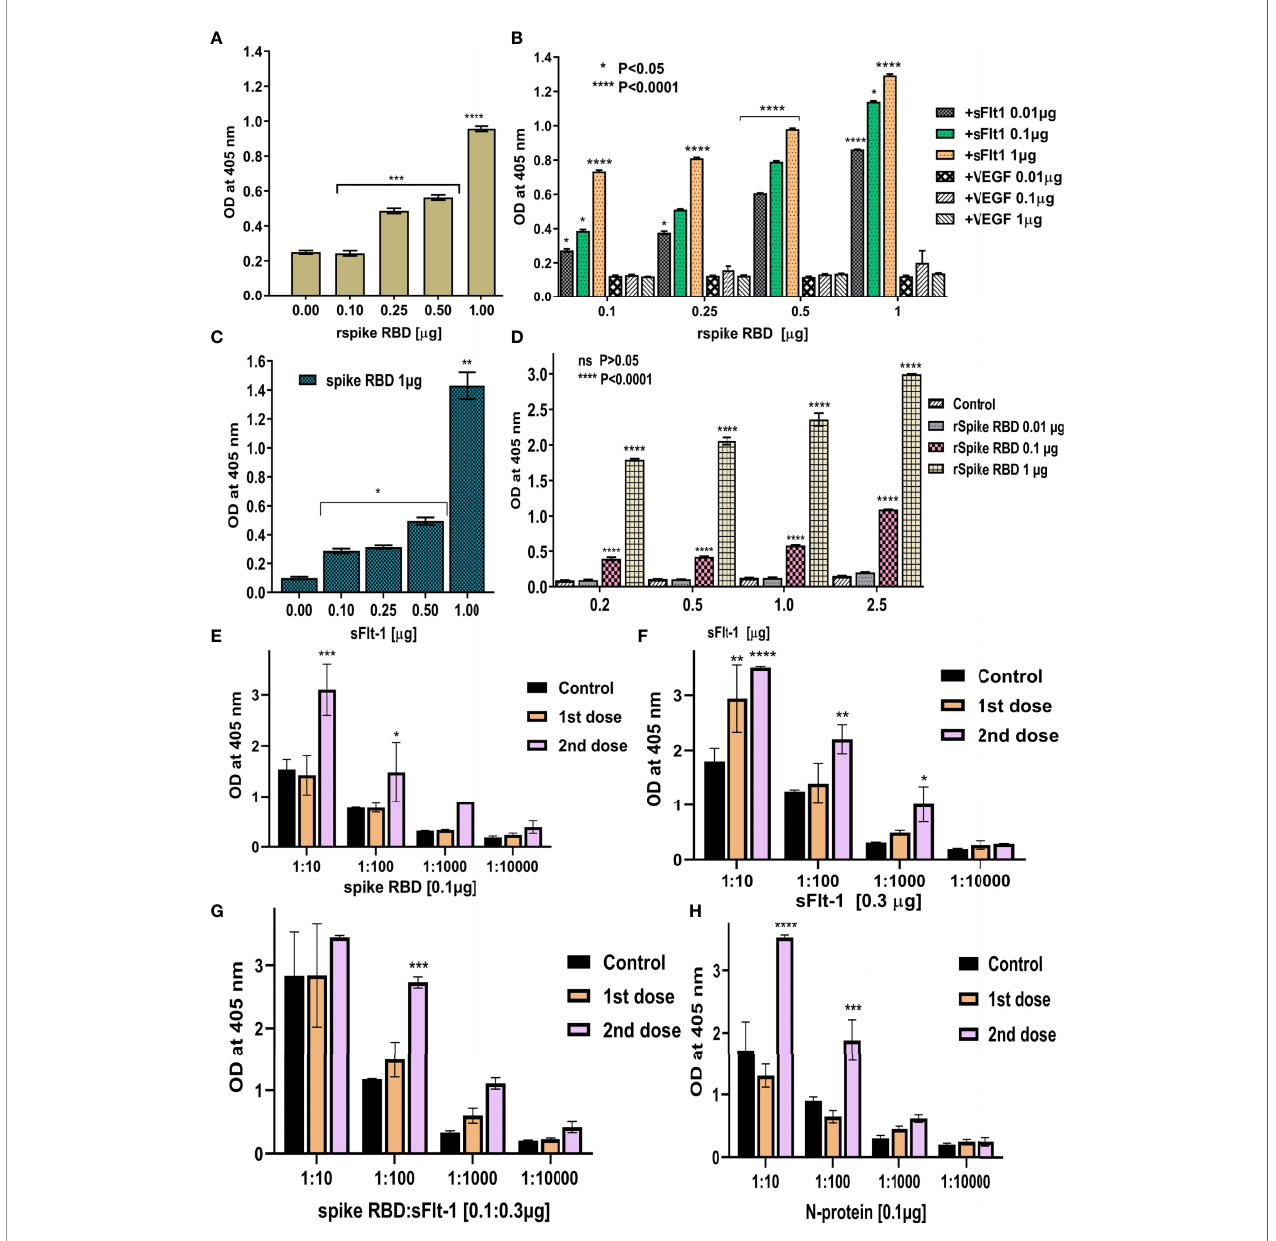
FIGURE 4 | Demonstrating the binding betweenrspikeRBDandrsFlt-1 using ELISA: (A) Bindingof anti-sFlt-1 antibodyto spike-RBDimmobilized ontheELISA plate, control is without spikeRBDimmobilization. Itcon fi rms normaldistributionbybothShapiro-WilkandKolmogorov-Smirnovtest andsigni fi cantdeviationfrom zero (P<0.0001) was observedbysimplelinear regressiontest. (B) Bindingof serial dilutions (0.01,0.1, and1µg) ofrsFlt-1 toincreasedconcentrationsof rspikeRBDimmobilizedonthe ELISA plate andprobed withpolyclonalsFlt-1 antibody. AdditionofVEGFto the wellsimmobilizedwithspikeRBDinsteadof sFlt-1 was usedascontrol. (C) Binding ofserialdilutions ofrsFlt- 1(0.1, 0.25, 0.5 and1µg) immobilizedonELISA plateto spikeRBD (0.1 µg) whichfurther probed withanti-spikeantibody.Controlis without sFlt-1 immobilization. One-sample t test (two-tailed) was used to compare betweentest andcontrolgrouprevealedsigni fi cantincrease insignaluponspikeRBD addition(P value =0.0036). (D) Bindingof serial dilutions ofrsFlt-1 (0.2, 0.5, 1 and2.5µg) immobilizedonELISA plate to increasedconcentrations ofspike RBD(0.01, 0.1and1µg) whichfurther probedwithanti-spike antibody. WellscoatedwithVEGF wereusedascontrol. (E – H) ELISA assaysto testthe cross-reactivityfor rspike RBD, sFlt-1, spikeRBD-sFlt-1,or nucleocapsidprotein immobilizedontheELISA platesto thehumananti-spikepolyclonalantibodies(1:10, 1:100, 1:1000and1:10000 dilutions) from vaccinateddonors(dose 1and2) versus non- vaccinateddonorsas anegative control. Error bars depictedmean SEM ±SD, Statisticaltestfor normal distributionof panels (B, D) using Shapiro-Wilktestcon fi rms normality. Further, two-wayANOVA wasusedfor multiplegroupscomparisonbyTukey andDunnett ’ s multiple comparisons tests in panels (B, D) respectively. Panels (E – H) con fi rms normaldistributionbyShapiro-Wilktest followedbytwo-wayANOVA Dunnett ’ s multiple comparisonstest wasapplied to compare betweencontrol (non-vaccinated) versus1 st and2 nd dose ofvaccinated serum, P-valuesindicate statisticalsigni fi cancecompared to controlgroups (*P<0.05, ** P<0.01, *** P<0.001, ****